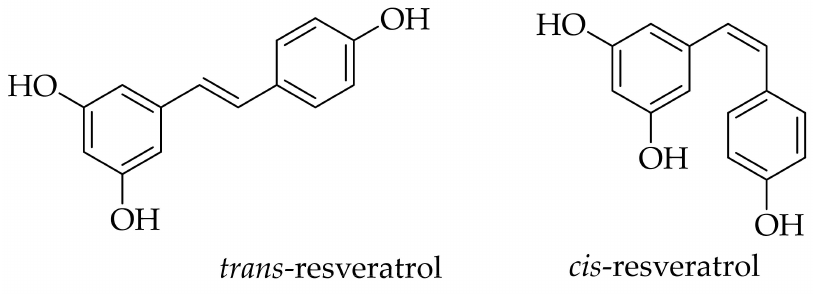
Figure 1. The chemical structures of the trans and cis isomers of